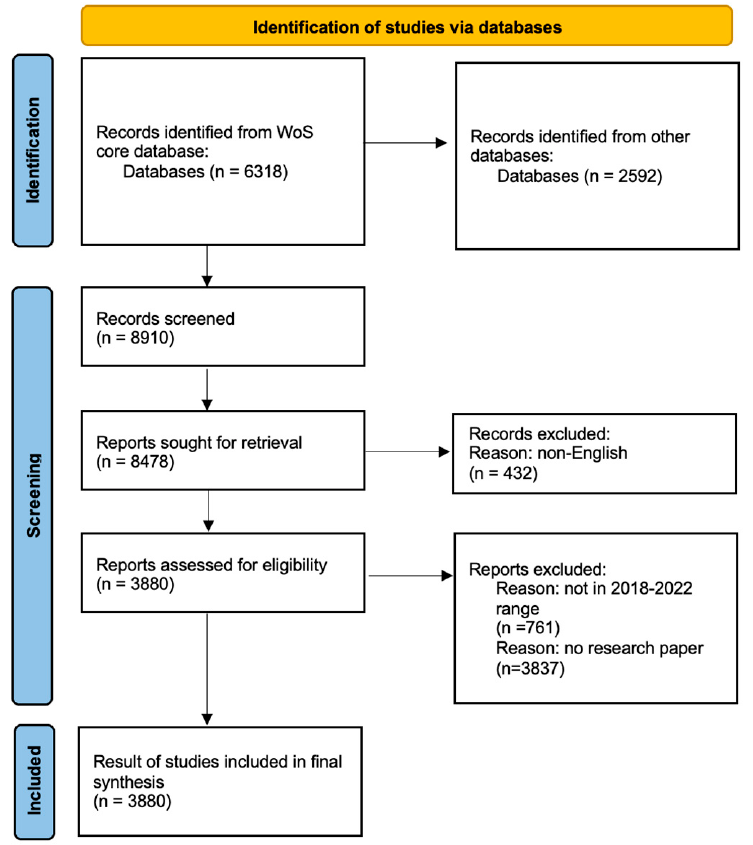
Figure 2. PRISMA flowchart.